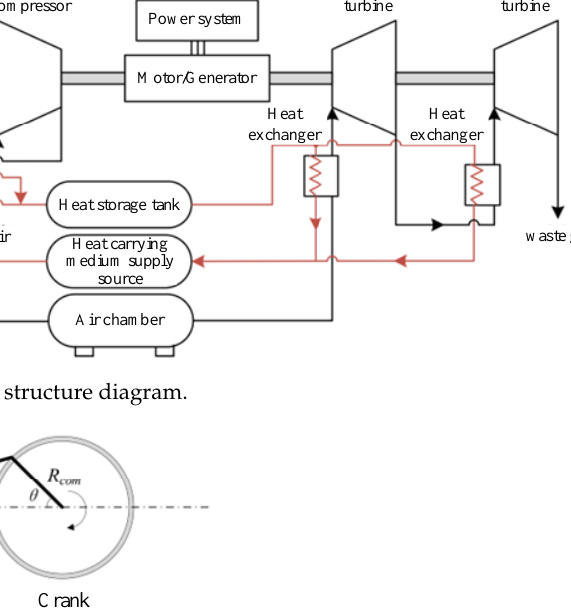
Figure 4. AA-CAES system structure diagram.